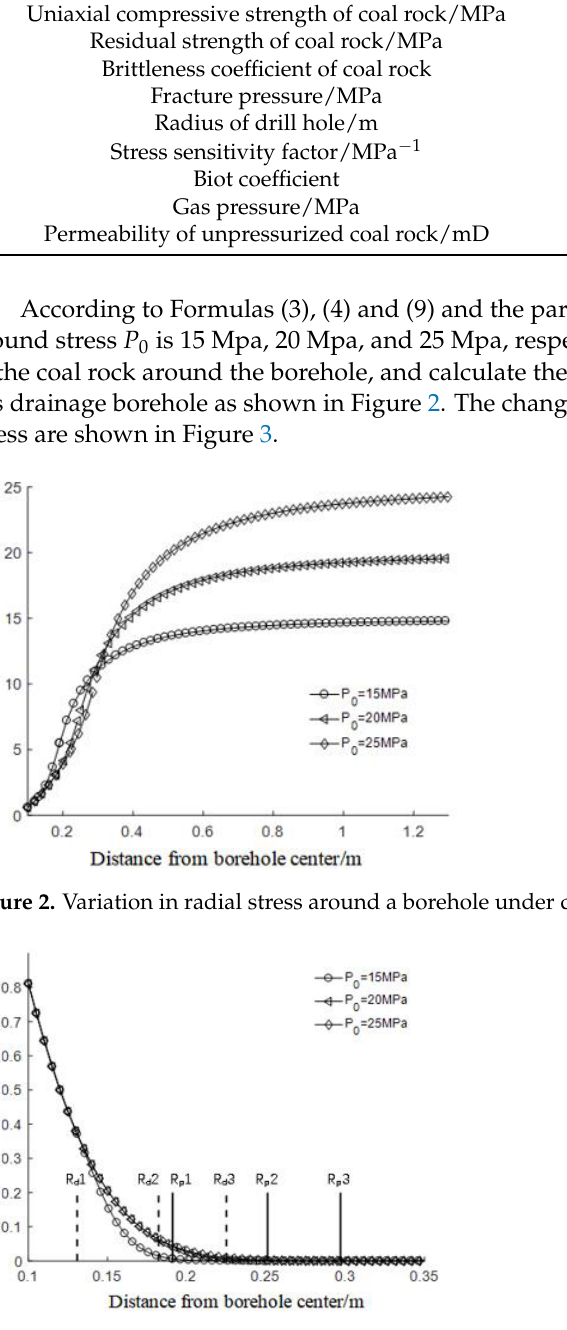
Figure 3. Variation in the permeability of coal rock around a borehole under different ground stresses.